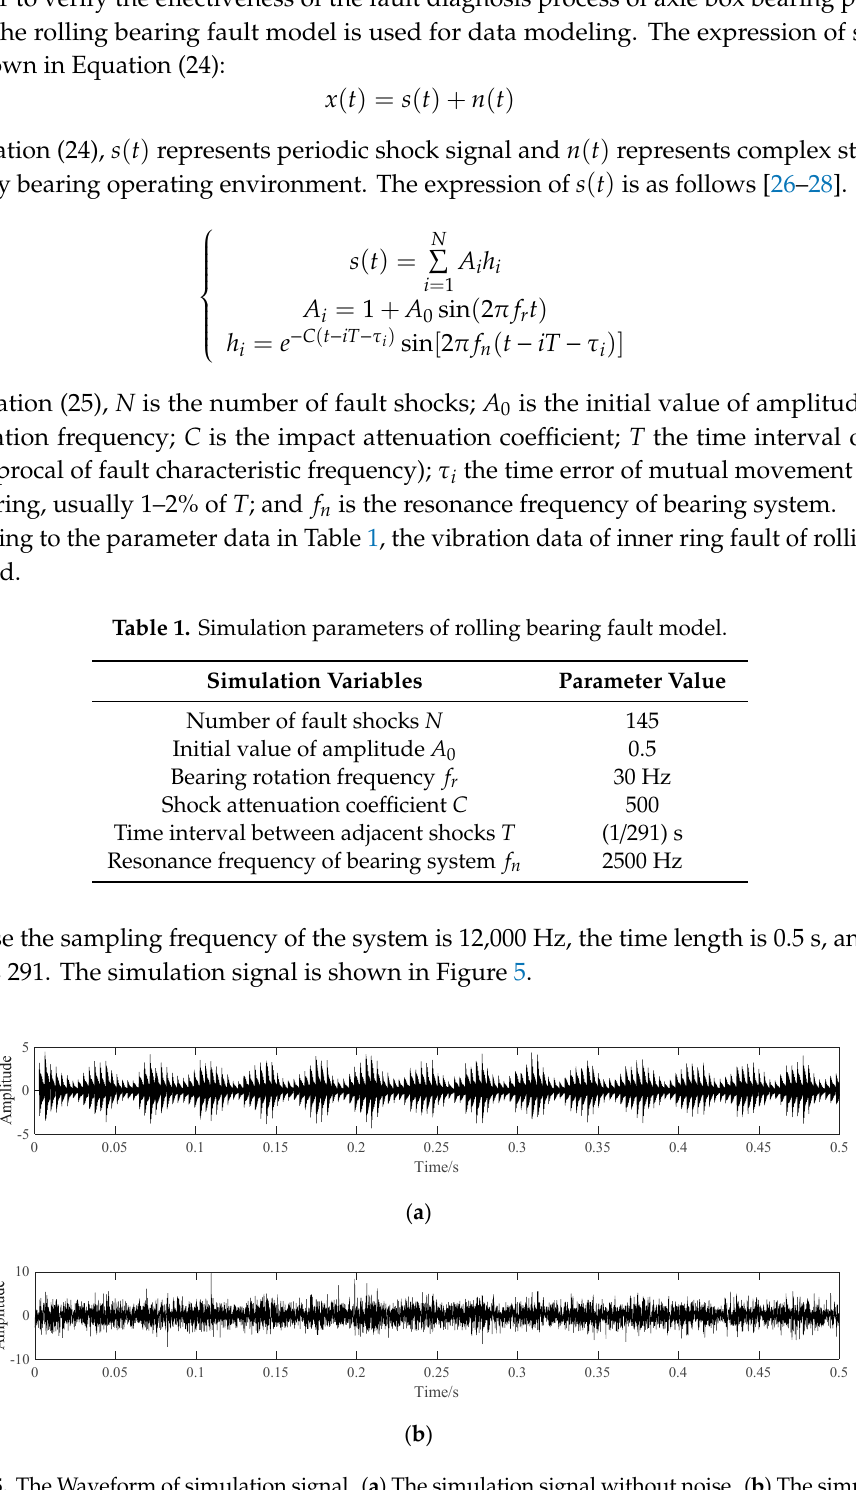
Figure 5. The Waveform of simulation signal. ( a ) The simulation signal without noise. ( b ) The simulation signal with noise.